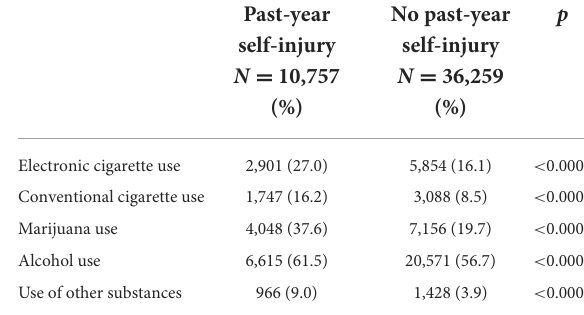
TABLE 1 Demographic overview of study sample, by past 12-month self-injury.